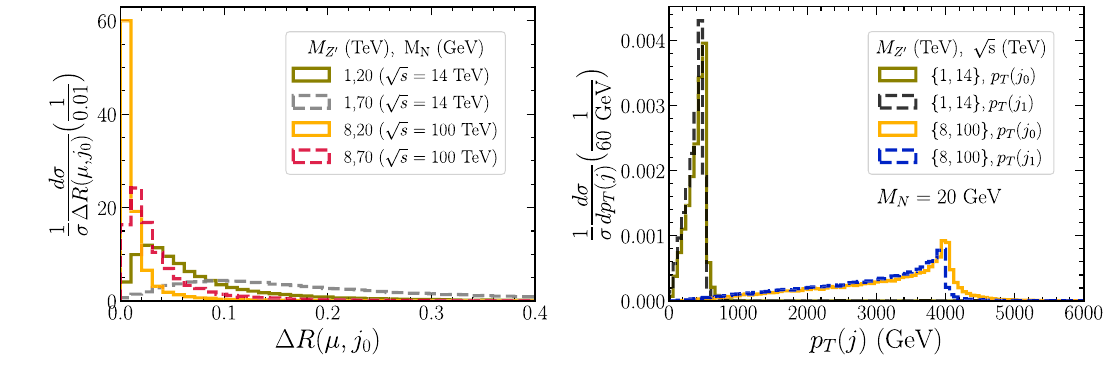
Fig. 9 Left: (cid:2) R separation between the μ and leading jet. Right: transverse momentum distribution of the leading and sub-leading fat-jet